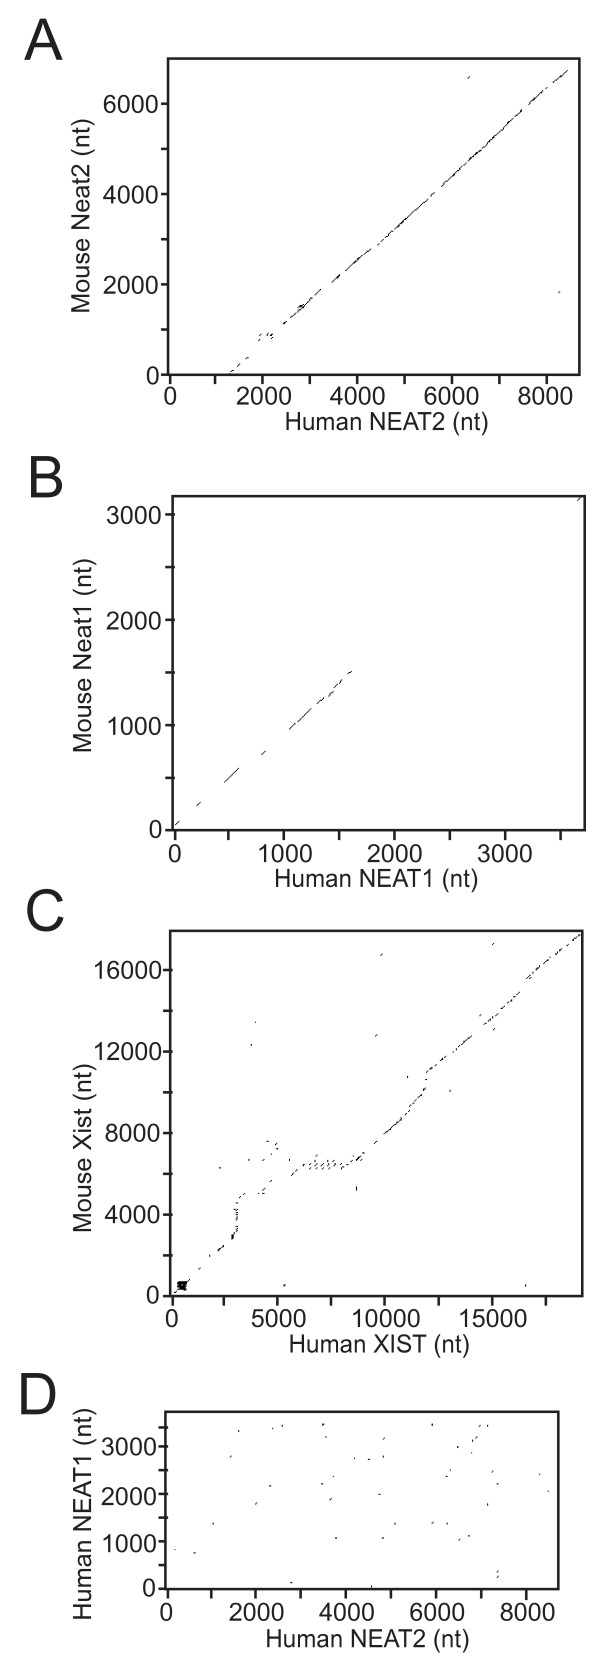
Comparison of NEAT1 and NEAT2/MALAT-1 between the human and mouse genomes. (A) The dot plot details the unspliced 8708 nt of the human NEAT2/MALAT-1 transcript as compared to the 6982 nt mouse Neat2/Malat-1 transcript and shows strong conservation across the length of the NEAT2/MALAT-1 transcript. (B) The dot plot details the 3729 nt human NEAT1 transcript as compared to the 3177 nt mouse Neat1 transcript. Two islands of relatively high identity were identified by this comparison: nucleotide position 483–597 of human NEAT1 and 450–565 of mouse Neat1 show 87% identity, and nucleotide position 1113–1368 of human NEAT1 and 1013–1238 of mouse Neat1 show 80% identity. (C) A dot plot with identical parameters between the primary human and mouse XIST transcripts is shown for comparison. (D) A dot plot between human NEAT1 and NEAT2/MALAT-1 with a 50% identity cutoff demonstrates the lack of conservation between the transcripts.